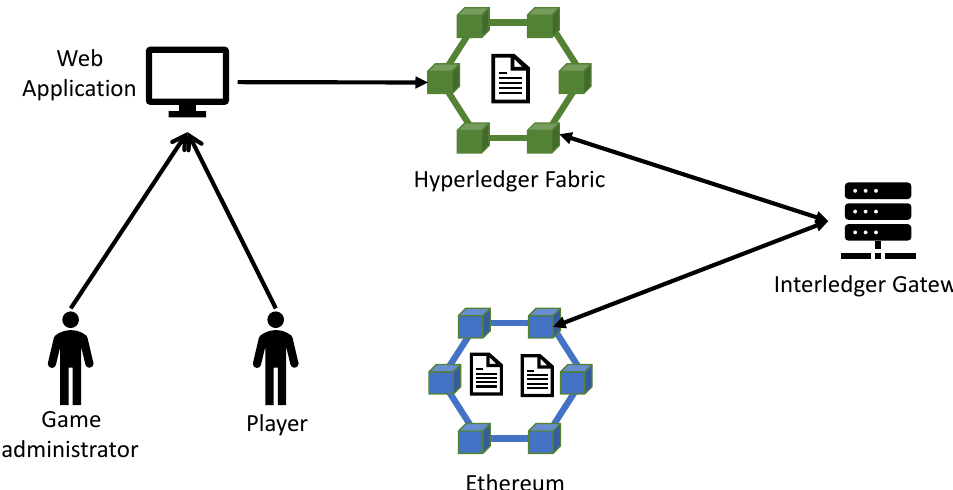
Figure 1. Architecture diagram for the emulation environment involving two blockchains that are interconnected through an Interledger